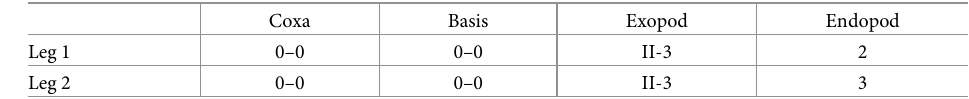
PLOS ONE | https://doi.org/10.1371/journal.pone.0281013 March 7,